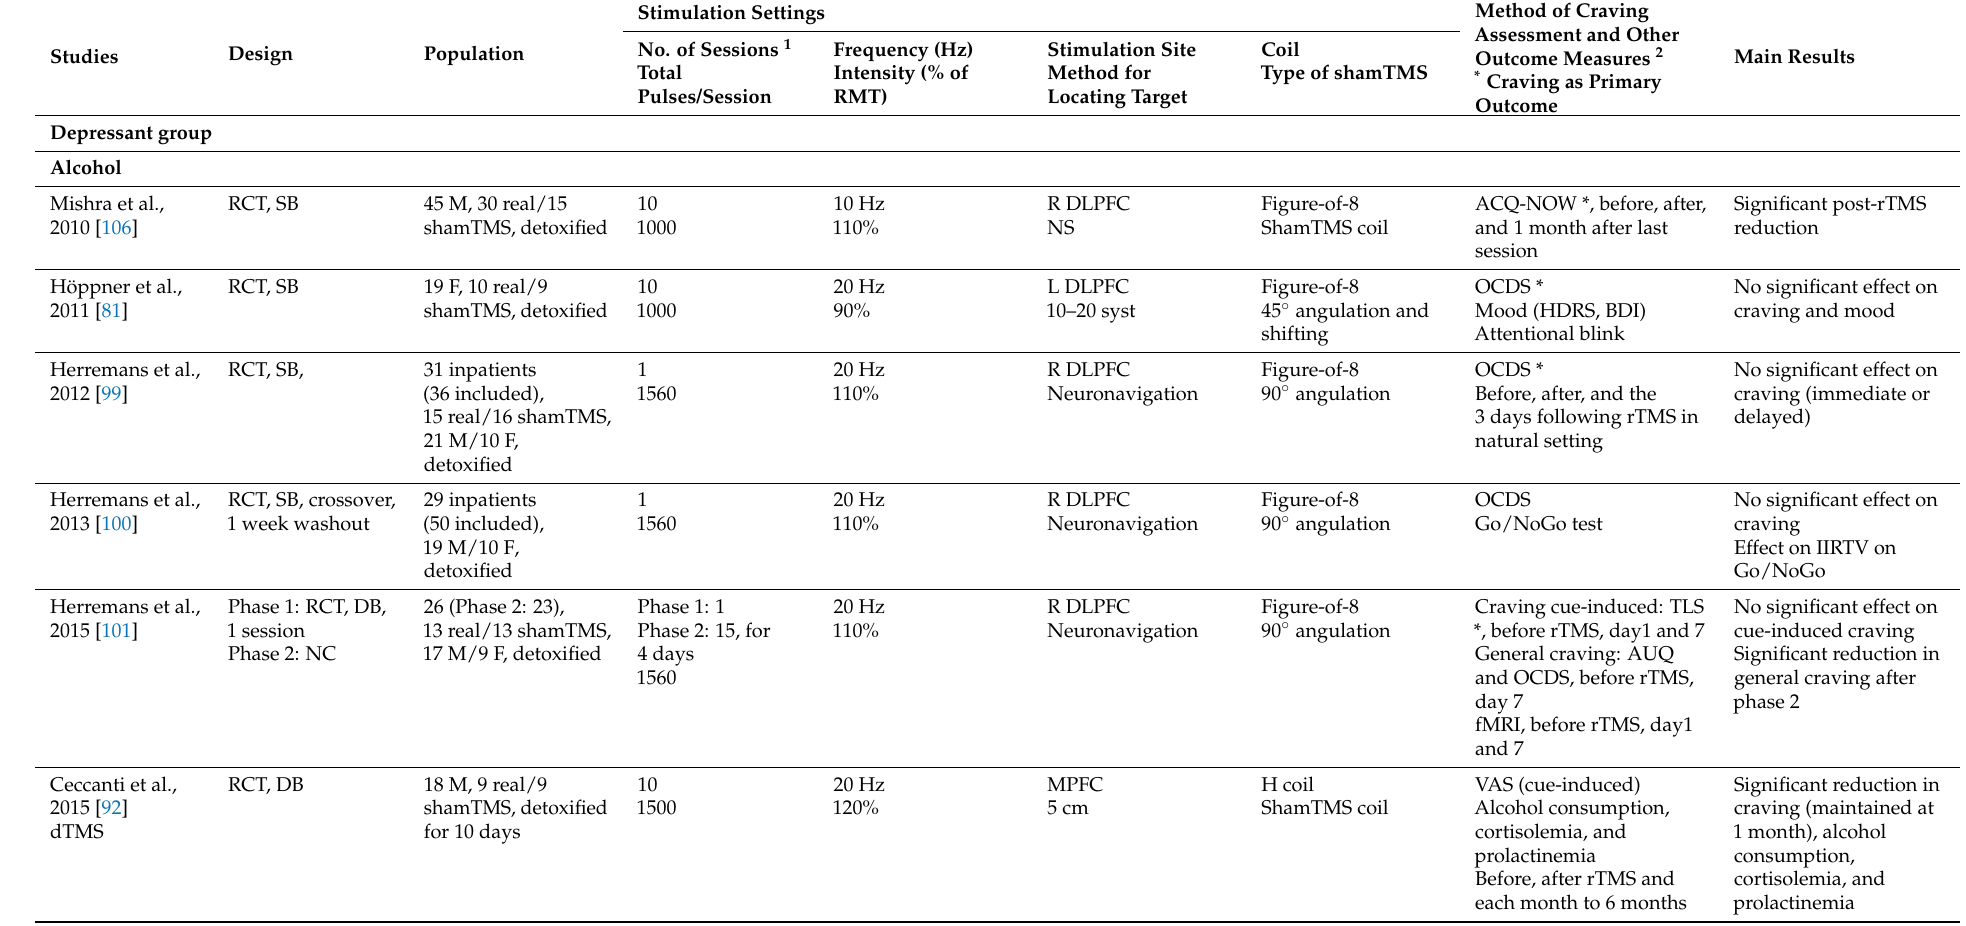
Table A1. Characteristics of studies included in the meta-analysis ( k = 34).